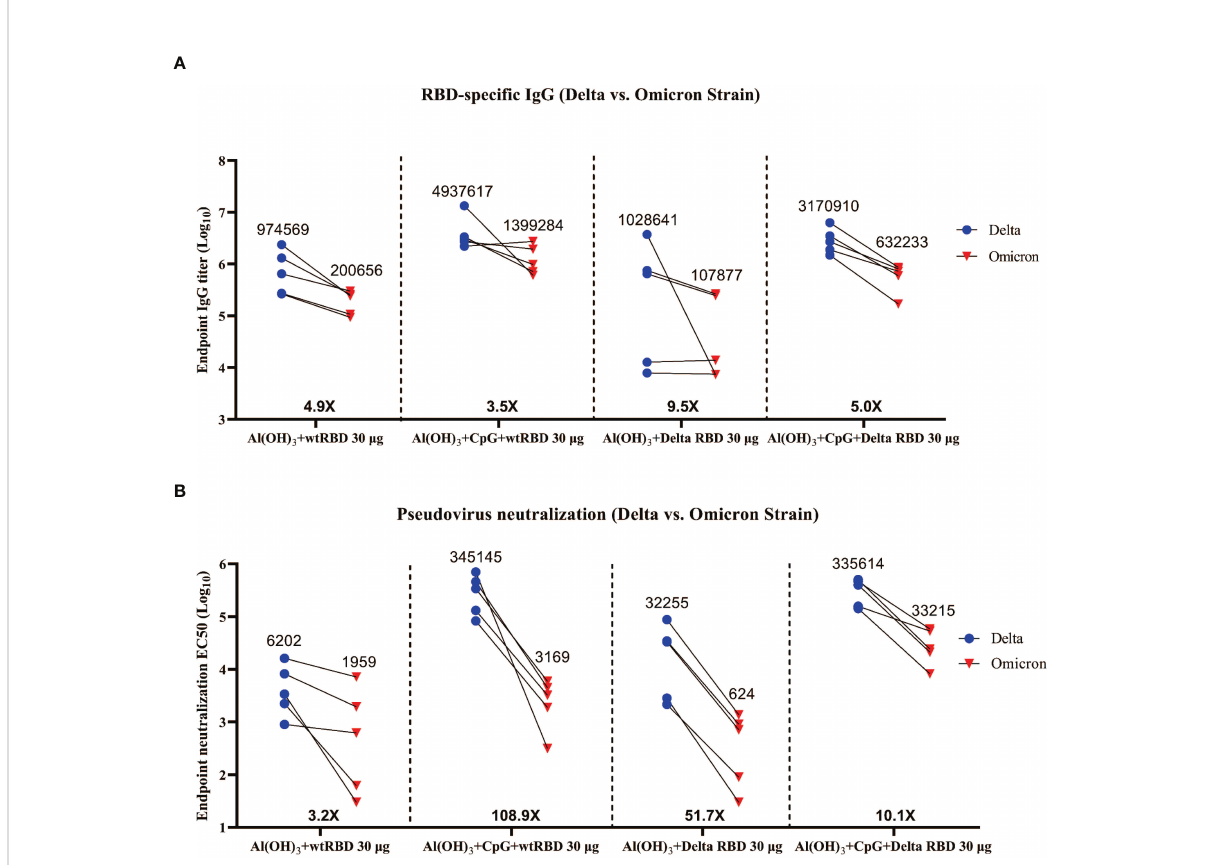
FIGURE 6 Cross-reactivity of the antisera from mice immunized with wtRBD or Delta RBD against the Omicron variant. The endpoint (day 84) serum samples from the mice immunized with 30 m g Delta RBD (Figure 5A) or wtRBD (Figure S6) were used for the IgG binding antibody and NAb assays. (A) Measurement of the titers of the Omicron RBD-speci fi c IgG antibodies. (B) Measurement of the NAb titers against Omicron. Each symbol indicates data from one mouse (n = 5 mice/group); geometric means of each group are